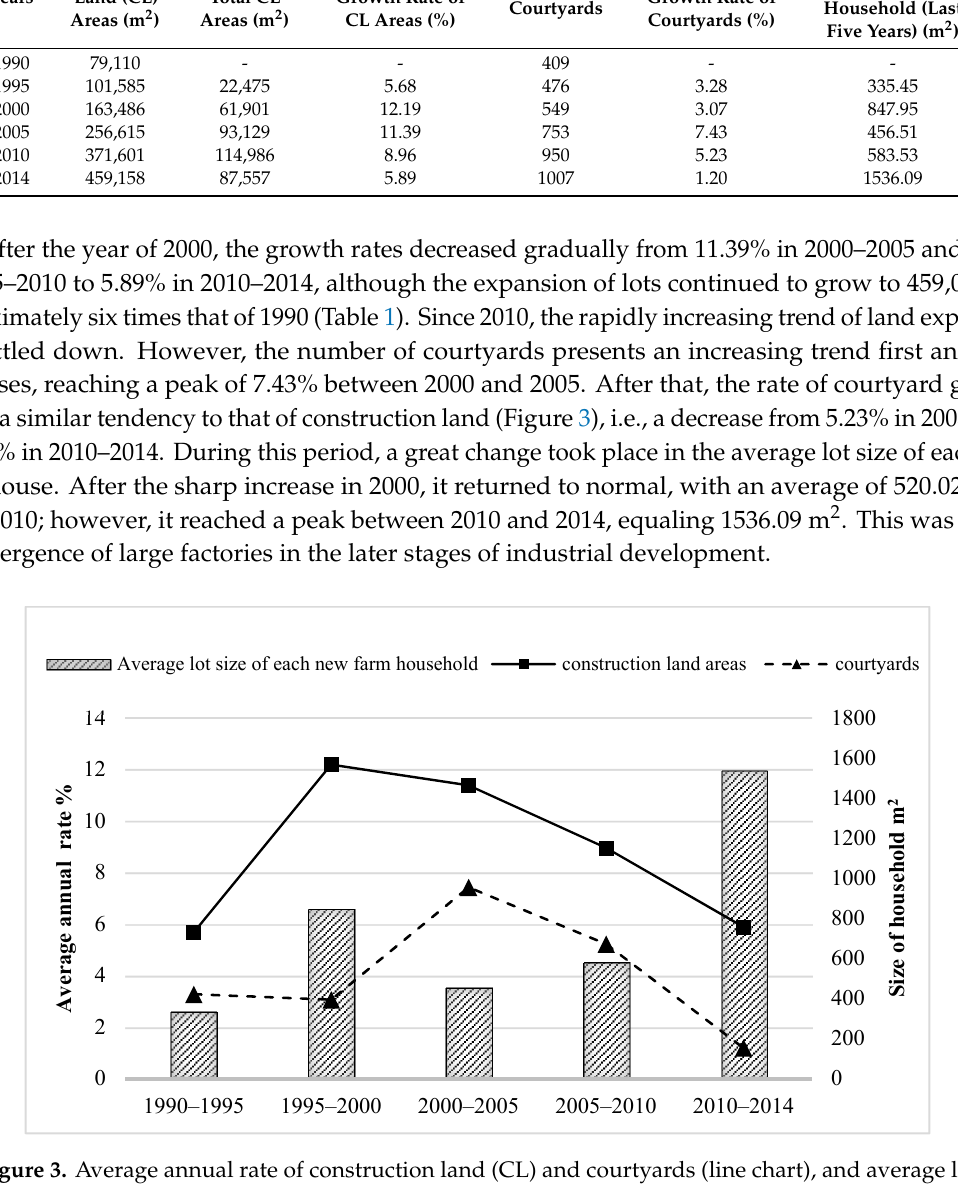
Table 1. Construction land (CL) and courtyard changes in Fengzhuang from 1990 to 2014.